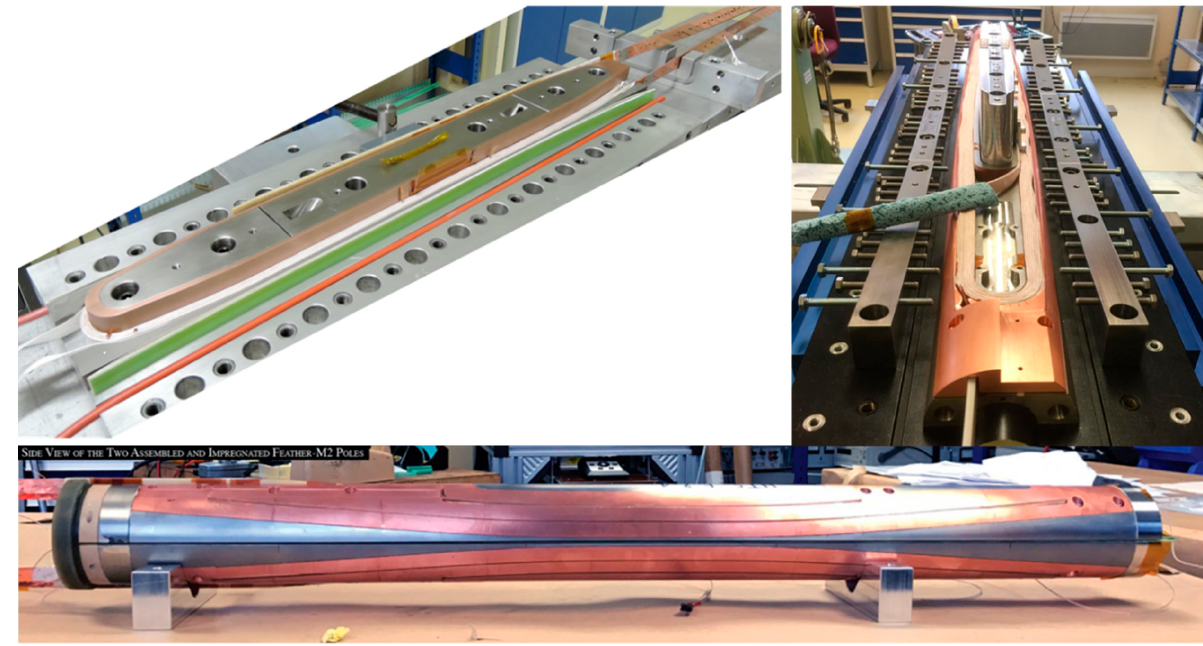
Figure 19. FeatherM0.5 coil after construction ( top left ). AB dipole FeatherM2.3-4 during winding ( top right ) and once assembled before yoking ( bottom ).